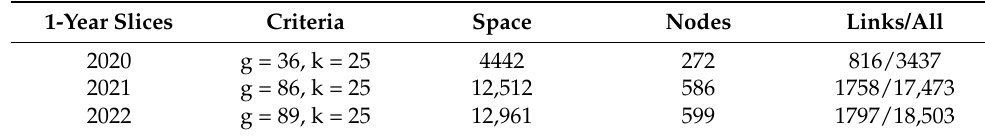
Table 3. Keyword co-occurrence network attributes in each